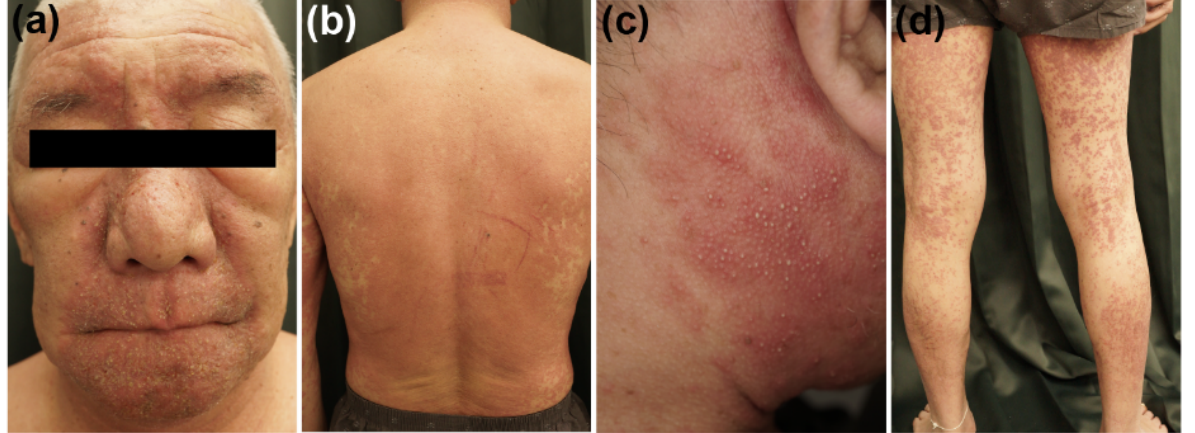
Figure 2. Clinical manifestations of DIHS/DRESS. ( a ) Facial erythema, scaling, and peri-orbital edema. ( b ) Diffuse erythematous rash on the back. ( c ) Pustules on the face. ( d ) Purpura on the legs.